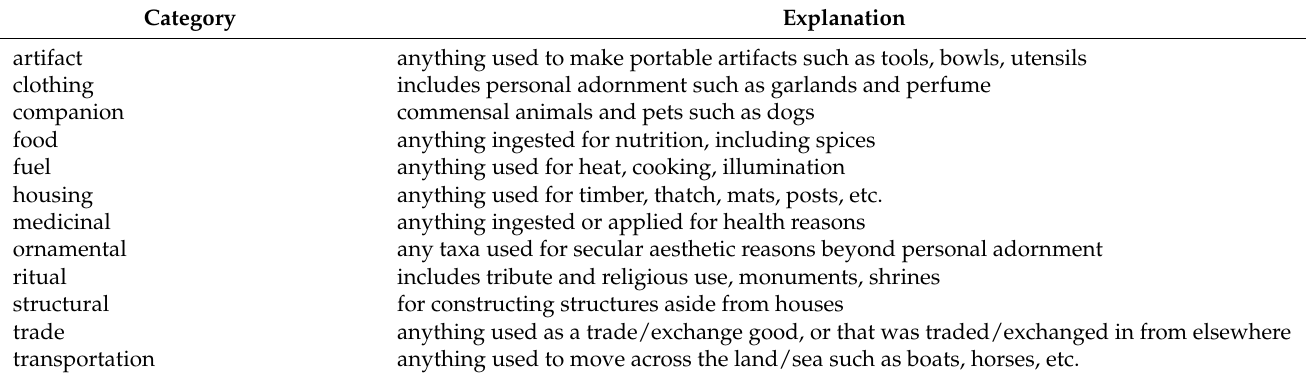
Table 2. Categories used in this analysis identified by ArchaeoEcology Project